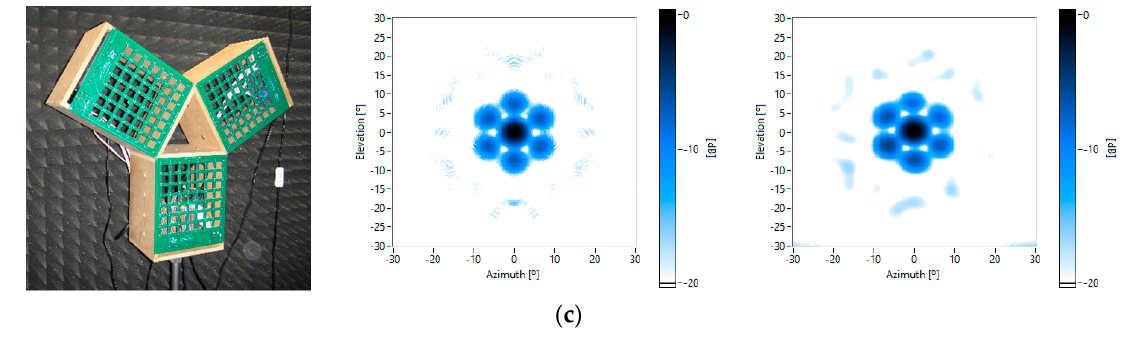
Figure 10. Cluster (col. 1), theoretical (col. 2) and measured beampatterns (col. 3) for 8 kHz, pointed to the broadside. Cluster geometries: row ( a ); square ( b ); and star ( c ). The row cluster shows that the beamwidth in azimuth has been reduced by a factor of 3, increasing the angular resolution of the image in that direction. In the square cluster, the beamwidth in azimuth and elevation is halved. Finally, in the star cluster, a radial symmetrical pattern is achieved with a similar beamwidth in multiple